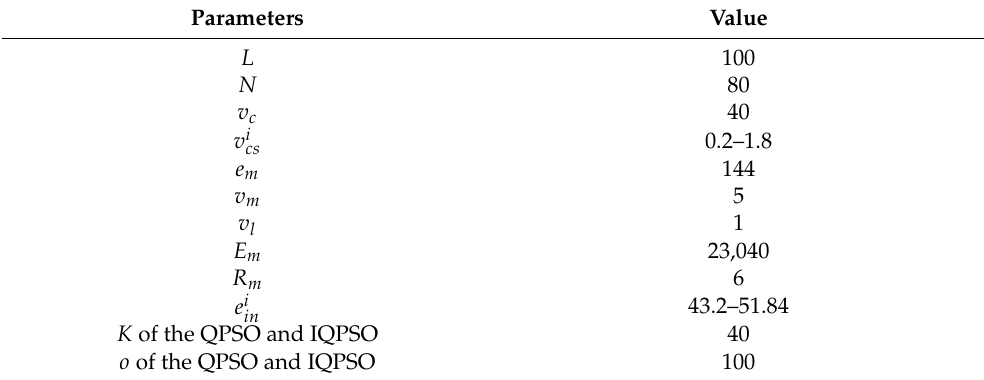
Table 1. Simulation